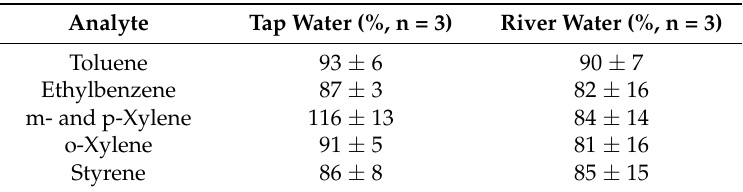
Recovery study for the target TEXS spiked to water samples analyzed using the SWNHs